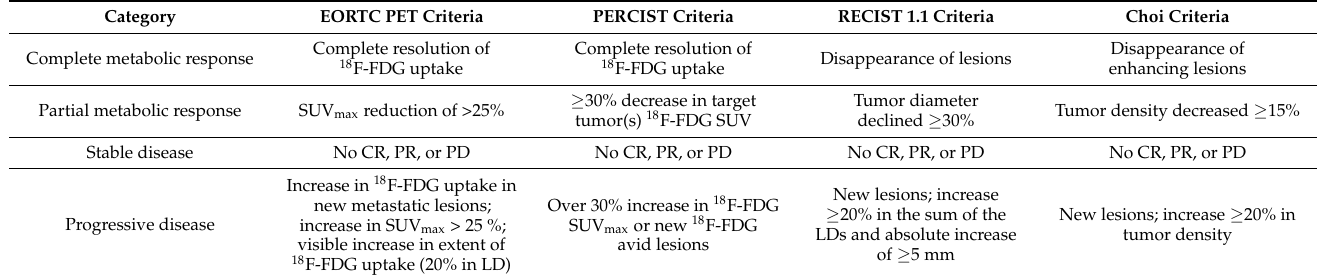
Table 1. Overview and comparison of international consensus-based criteria for 18 F-FDG-PET-CT evaluation (EORTC PET criteria and PERCIST criteria) [16] and CT evaluation (RECIST 1.1 criteria and Choi criteria) after systemic treatment and radioembolization